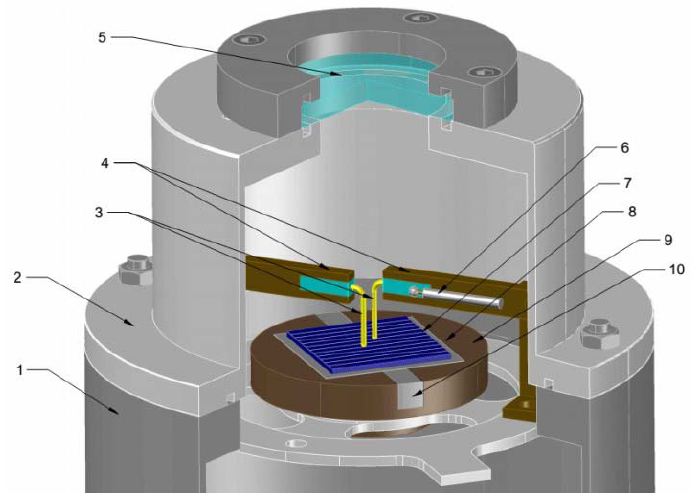
Figure 1. Low-temperature chamber: General view of the admittance measurement chamber: 1—microcryogenic machine body; 2—cell cover; 3—electrical contacts; 4—viewing window; 5—test sample; 6—mica insulator;